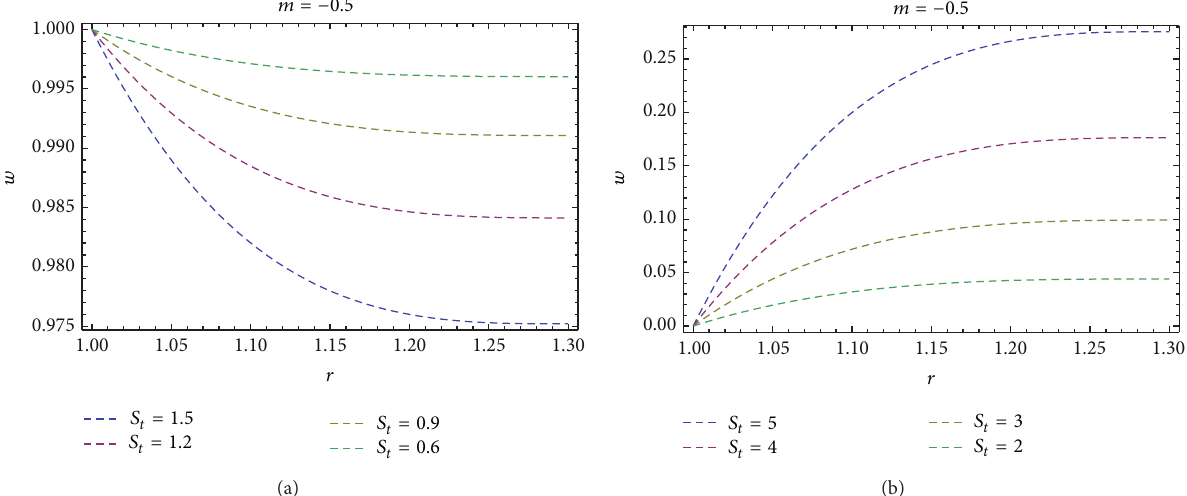
Figure 4: Effect on shear thinning fluid of 𝑆 𝑡 number on velocity for lifting problem (a) and drainage problem